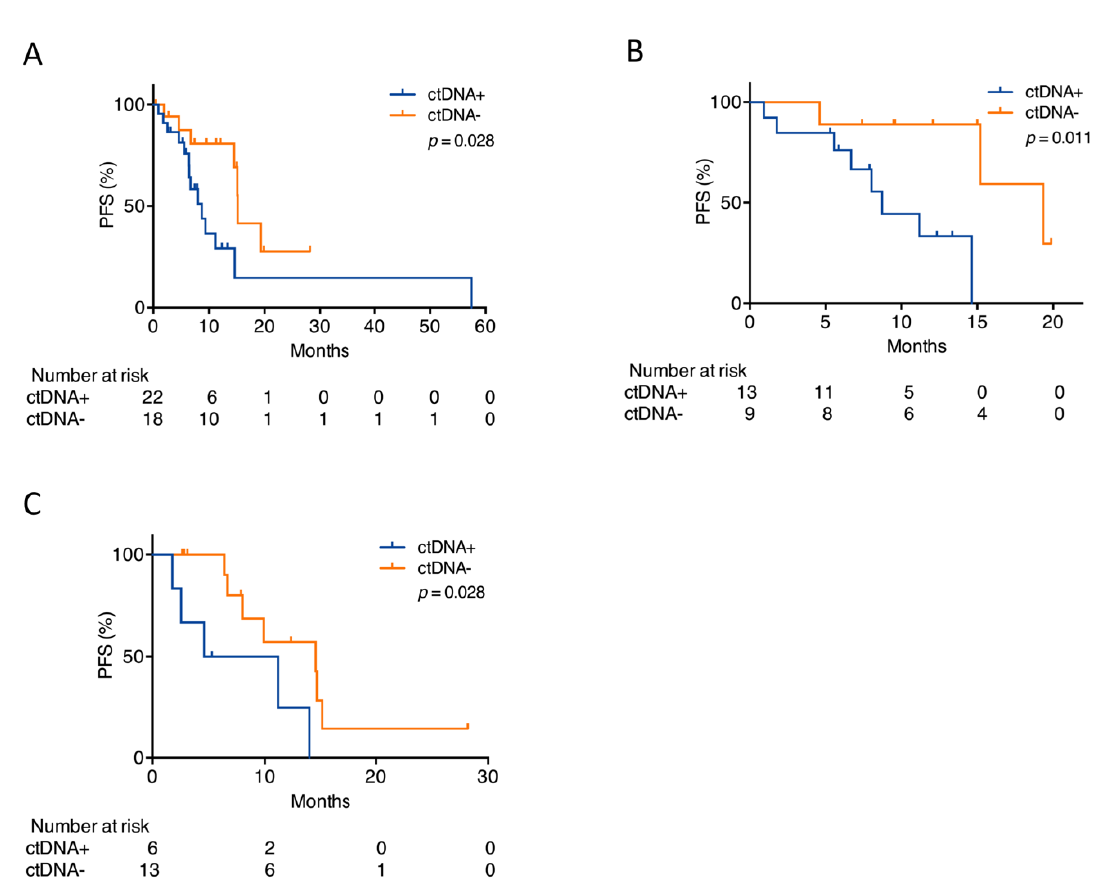
Figure 3. Detection of alterations before or early following ALK TKI start. ( A ) Kaplan–Meier plot for patients with detectable (ctDNA + ) or undetectable (ctDNA − ) alterations prior to start on any ALK TKI. ( B ) Kaplan–Meier plot for patients with detectable (ctDNA + ) or undetectable (ctDNA − ) alterations prior to alectinib start. ( C ) Kaplan–Meier plot for patients with detectable (ctDNA + ) or undetectable (ctDNA − ) alterations within the first two months on any ALK TKI. The p -values were determined by the log-rank test.